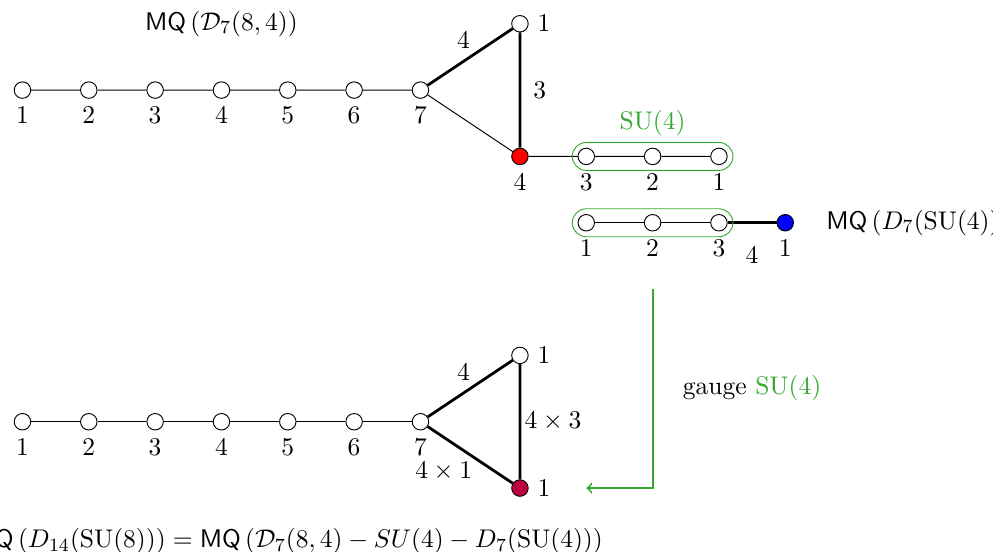
Figure 4 . Magnetic quivers ( MQ ) involved in gauging D 7 (8 , 4) and D 7 (SU(4)) to D 7 (8 , 4) − SU(4) − D (SU(4)) ∼ = D (SU(8)) . The SU (4) gauging seems to be realized in the following way as 7 14 an action on the magnetic quivers: The SU (4) which is gauged is the diagonal subgroup of the SU (4) global symmetries stemming from the balanced nodes highlighted in green in both original magnetic quivers. These two ‘tails’ are destroyed by gauging the SU (4) . Furthermore the red U (4) node, connected to the tail in the first quiver, and the blue U (1) node, connected to the tail in the second quiver, are identified. Since gcd(4 , 1) = 1 the resulting purple node should be a U (1) . However the nodes connected to the U (4) in the top quiver should keep their balance, hence some edge numbers are multiplied by 4 , resulting in the quiver at the bottom of the figure, which matches (4.36).